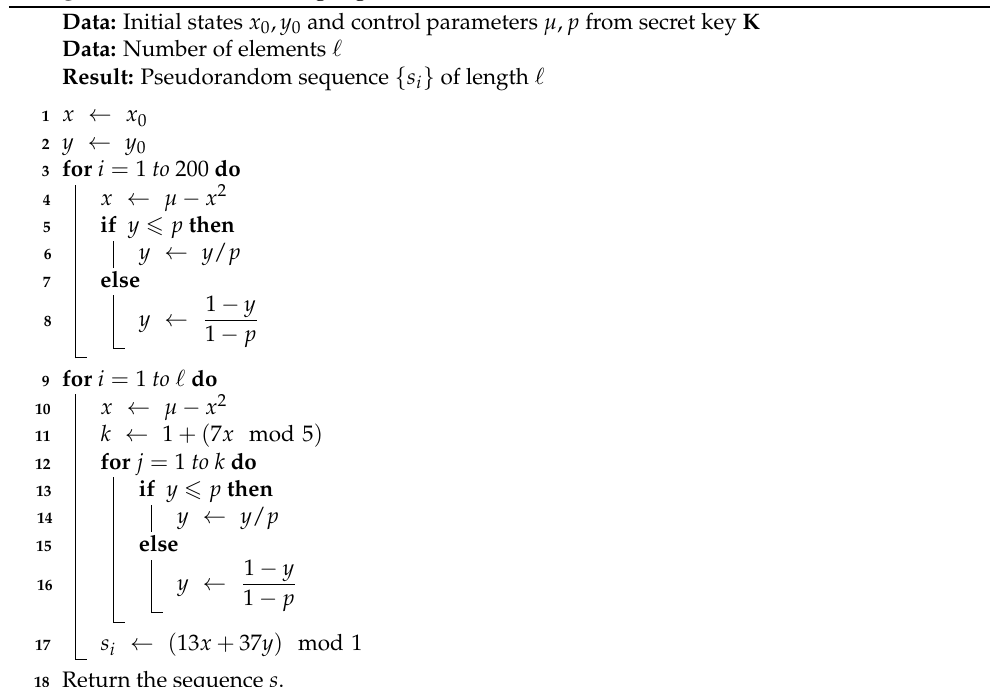
Algorithm 2: The chaining algorithm (Rule